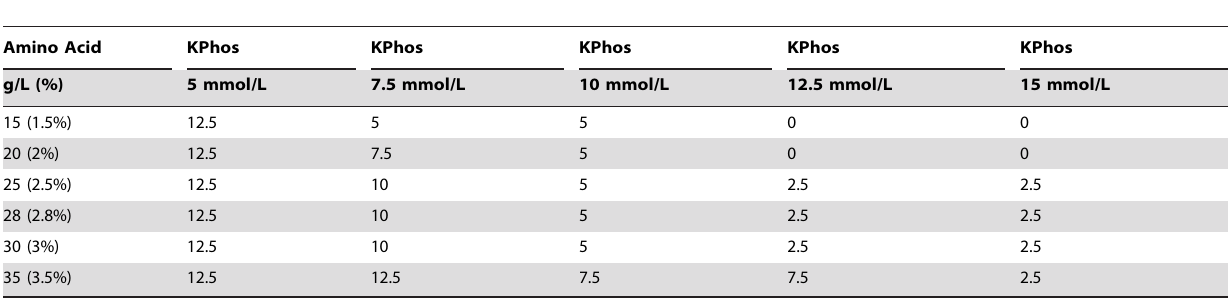
Table 4. Maximum Concentrations (mmol/L) a of Elemental Calcium (as CaCl 2 ) Allowable Without Precipitation at Various Premasol and Potassium Phosphate